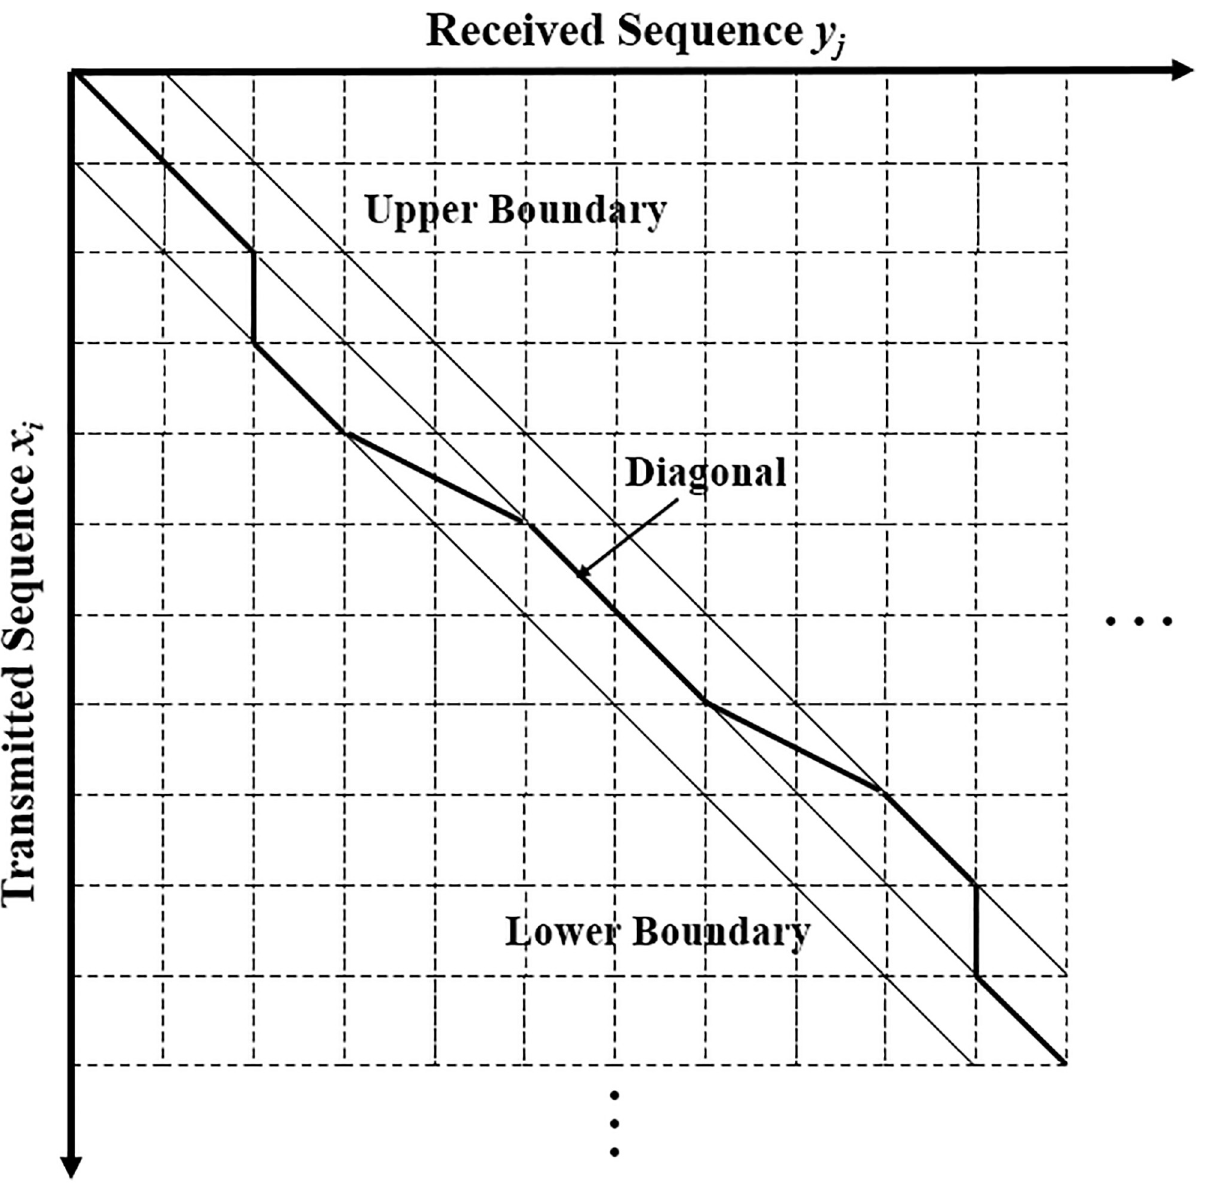
Fig 4. A complete transmission path representing a one-to-one mapping between the received and transmitted sequence on a two-dimensional grid diagram. The actual transmission path represented by the bold line over the CID channel is between the lower and upper boundaries.